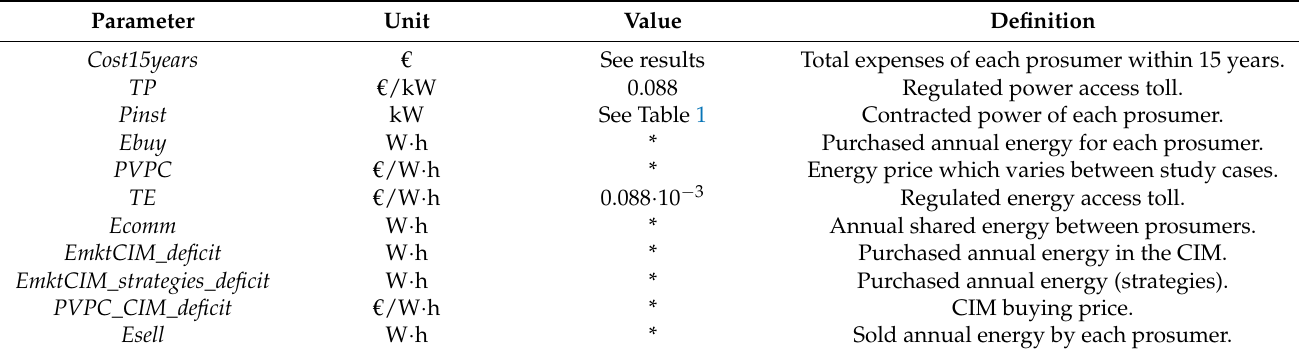
Table 3. Breakdown of the parameters in Equation (25).